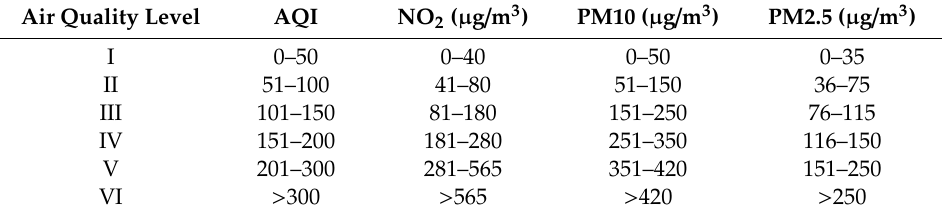
Table 2. The values of NO 2 , PM10, PM2.5 and AQI corresponding to di ff erent air quality